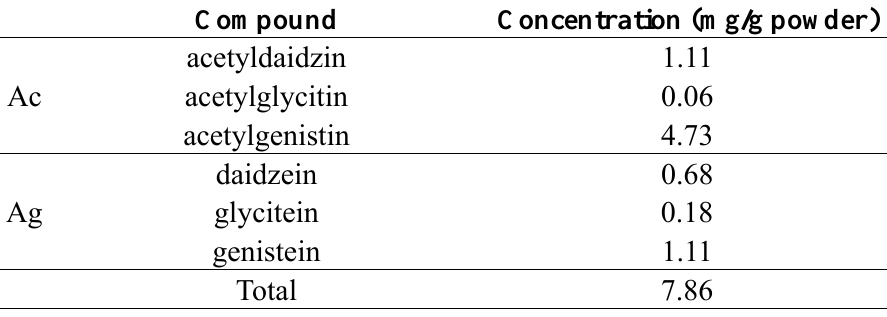
Table 1. The concentration of each isoflavone in Fraction